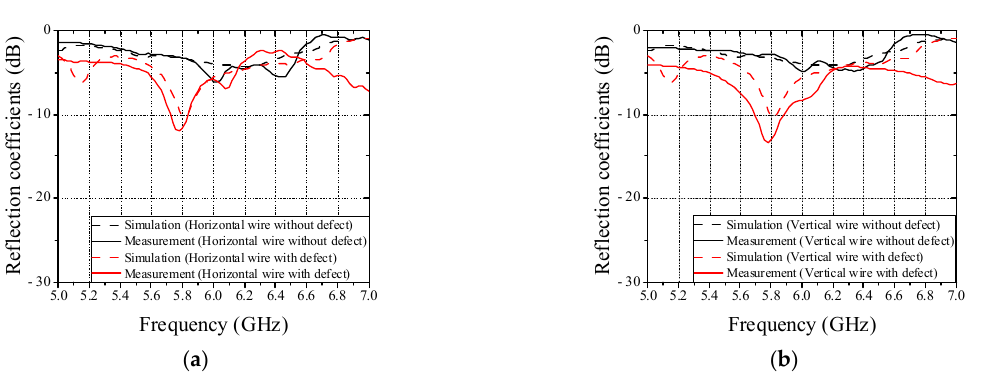
Figure 4. Structure of dual-feed patch antenna ( a ) Top view. ( b ) Side view. ( c ) Fabricated dual-feed patch antenna.